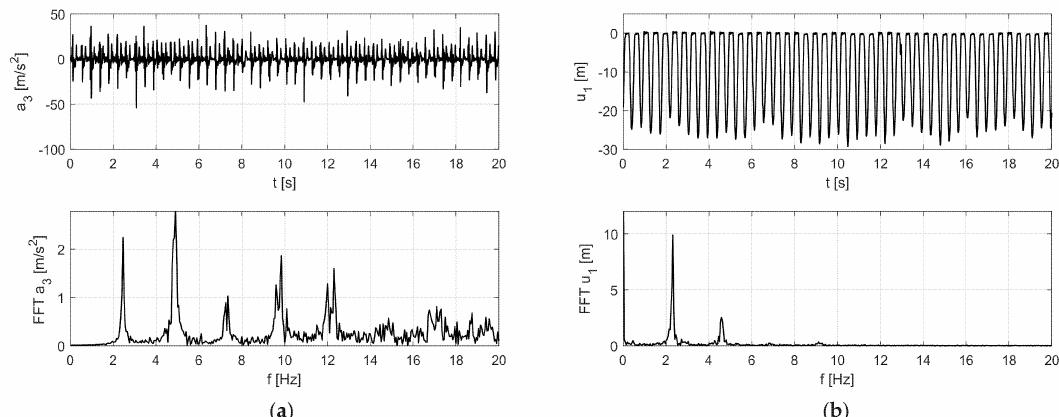
Figure 13. Results of vibrations in the form of ( a ) accelerations and ( b ) displacements recorded during the jumps of three people.